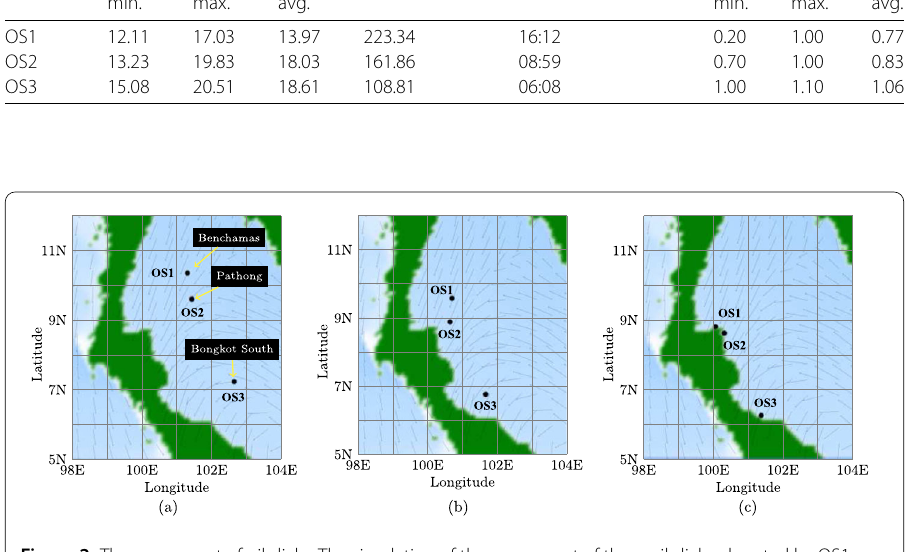
the fine weather day are larger than those on the day with the cyclone Pabuk. This is be- cause the wind direction varies in a great range. Therefore, a good management of oil spill would be greatly